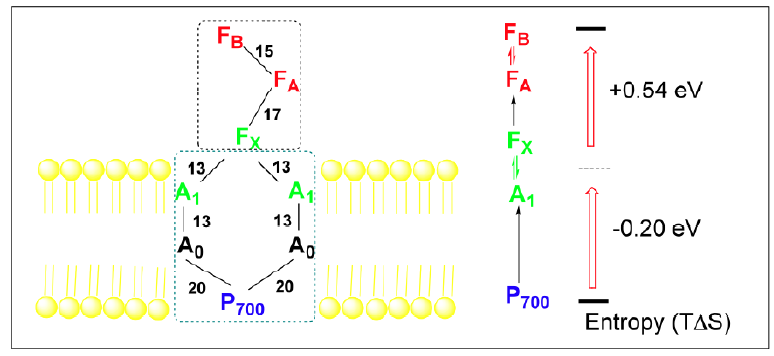
Figure 6. Thermodynamic and kinetic assignments of photoacoustic measurements in PS I of Synechocystis sp. PCC 6803 (reproduced with permission from the American Chemical Society